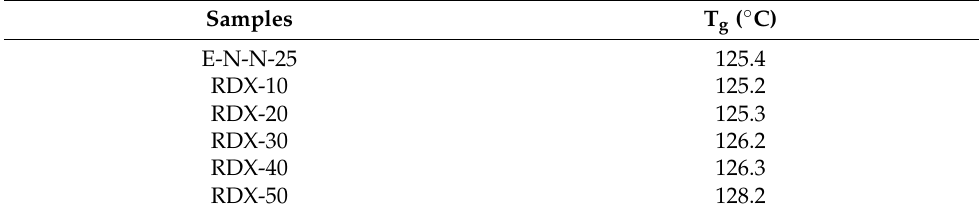
Table 4. T g values of RDX filler systems.